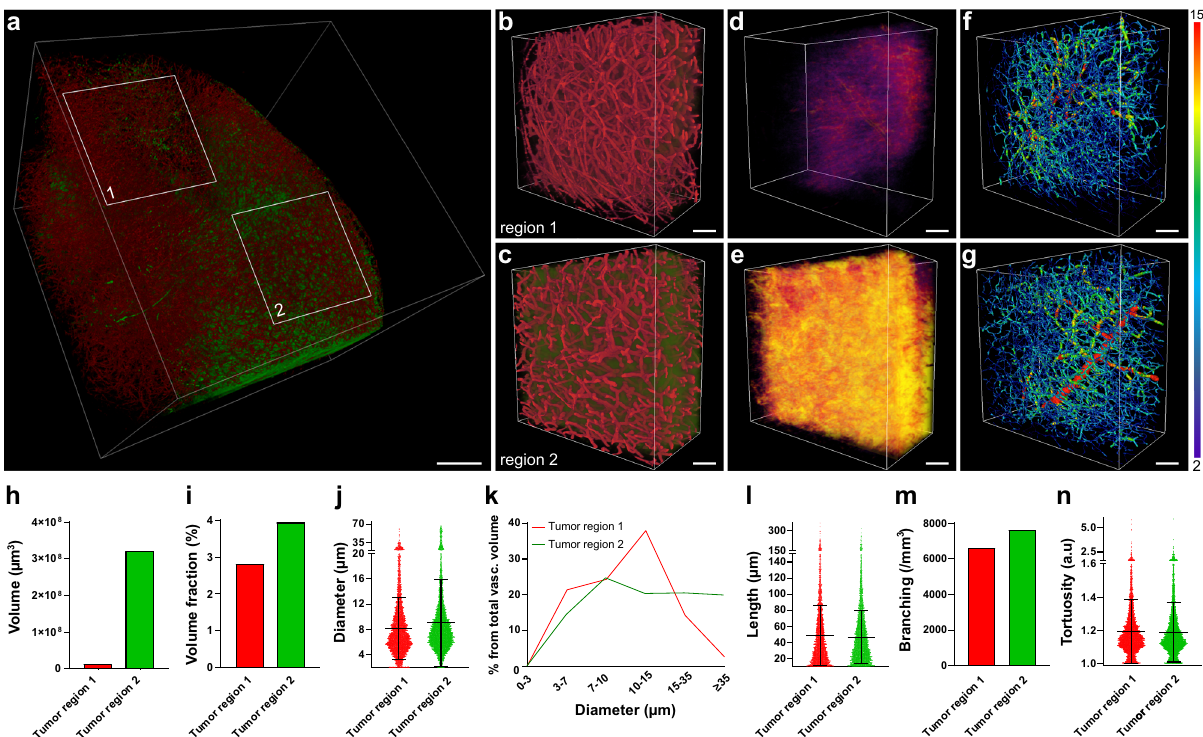
Fig. 7 Method application example: relationship between GBM vasculature permeability to TRITC-albumin and the angioarchitecture. a 3D rendering of a large data subset derived from a cleared tumor dissected from an animal after IV injections of TRITC-albumin (green) and AF647-lectin (red). Scale bar, 500 µ m. b , c 3D rendering of the regions marked in a in higher magni fi cation. d , e TRITC-albumin extravasation segmented by thresholding after subtraction of the segmented vasculature in the tissue subsets in b and c , the colormap re fl ects the density of the pixels in the extravasation mask. f , g Traced vasculature from the subsets in b and c colored according to the vessel diameter, numbers for minimum and maximum vessel diameter are presented in µ m. Scale bars, 100 µ m. h Total volume of extravasation in the tissue subsets. i Vascular volume fraction in the tissue subsets. j Mean diameter of the vascular segments in tissue subsets. Data are presented as mean ± SD ( n = 4804 and 5387 individual vessel segments). k Histogram representing the volume fraction occupied by vessels of a certain diameter from the total vascular volume fraction in the tissue subsets. l Mean length of the vascular segments in the tissue subsets. Data are presented as mean ± SD ( n = 4804 and 5387 individual vessel segments). m Number of branching points per volume in the tissue subsets. n Mean tortuosity of the vasculature in the tissue subsets. Data are presented as mean ± SD, ( n = 4804 and 5387 individual vessel